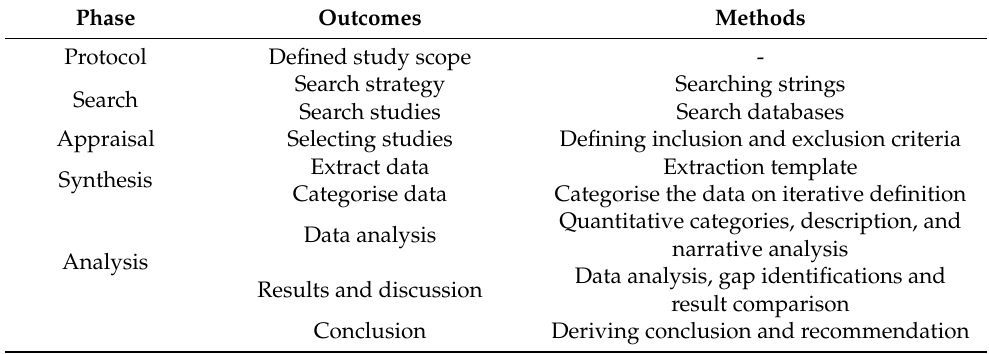
Table 4. Framework for